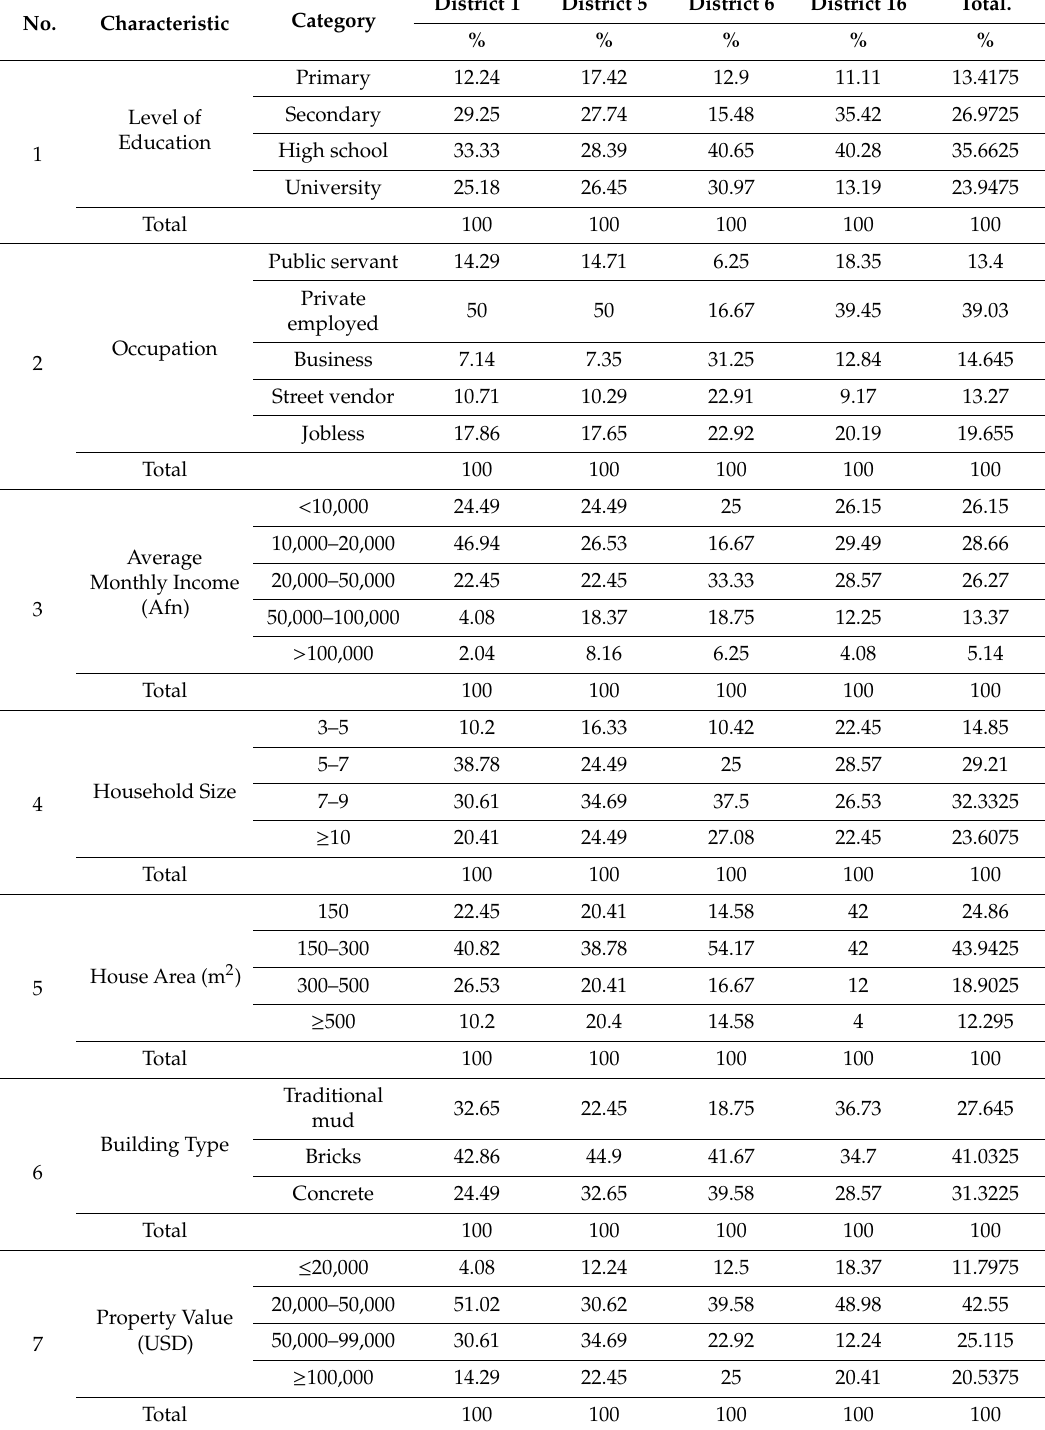
Table 1. Socioeconomic and environmental characteristics of study areas in Kabul City (based on author’s 2018